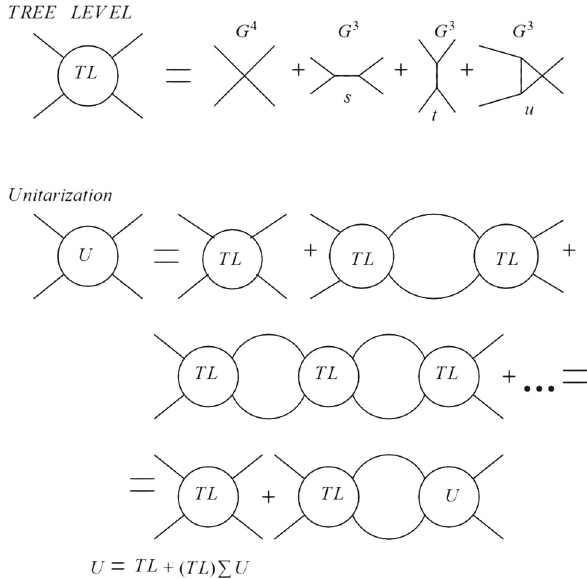
Fig. 2 Upper part: tree-level scattering diagrams. Lower part: sche- matic representation of the